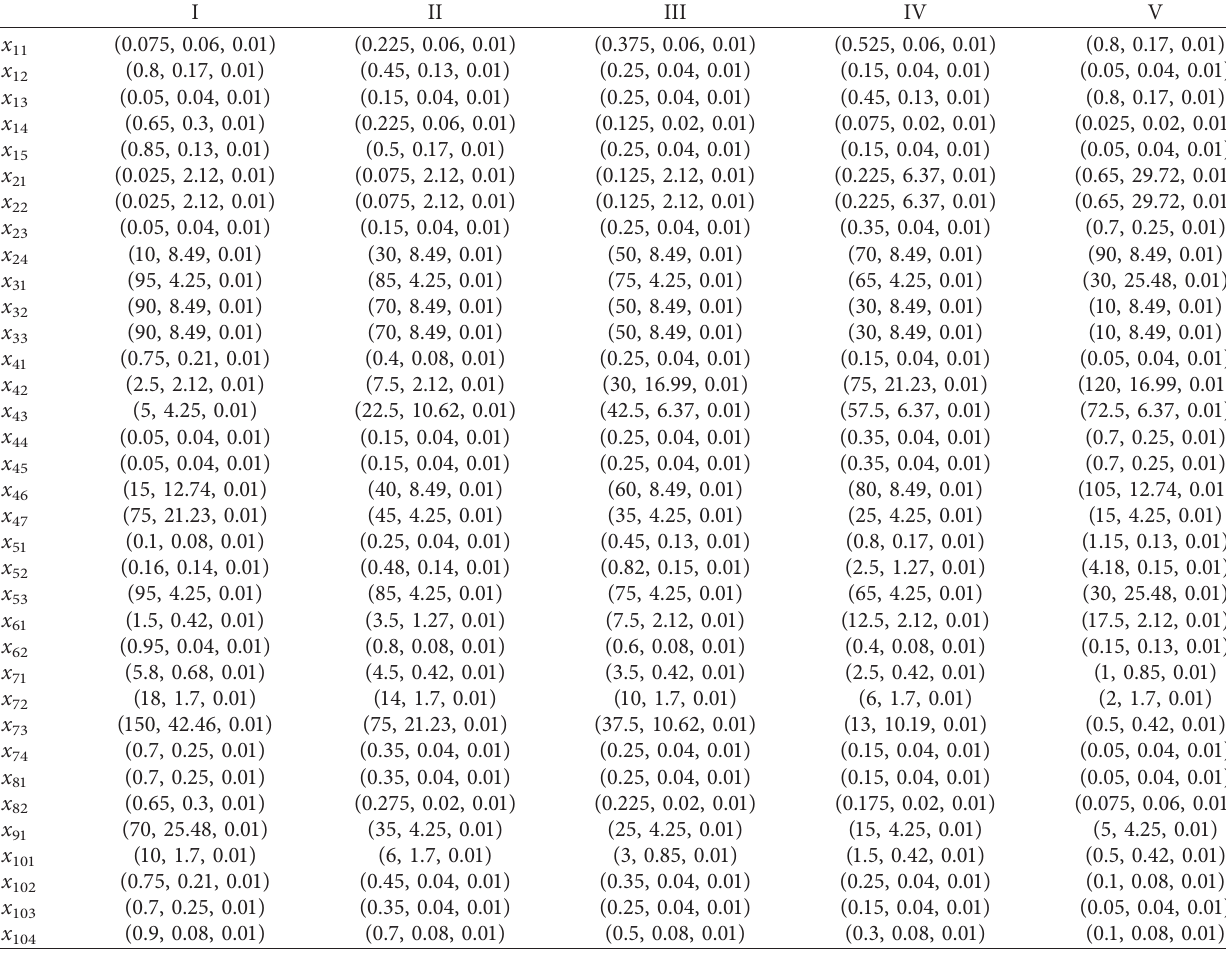
Table 3: Normal cloud parameters of vulnerability assessment indicators for reusing old industrial areas.